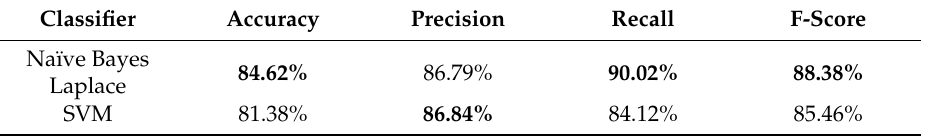
Table 2. Accuracies, precisions, recalls, and F-score in di ff erent classifiers.